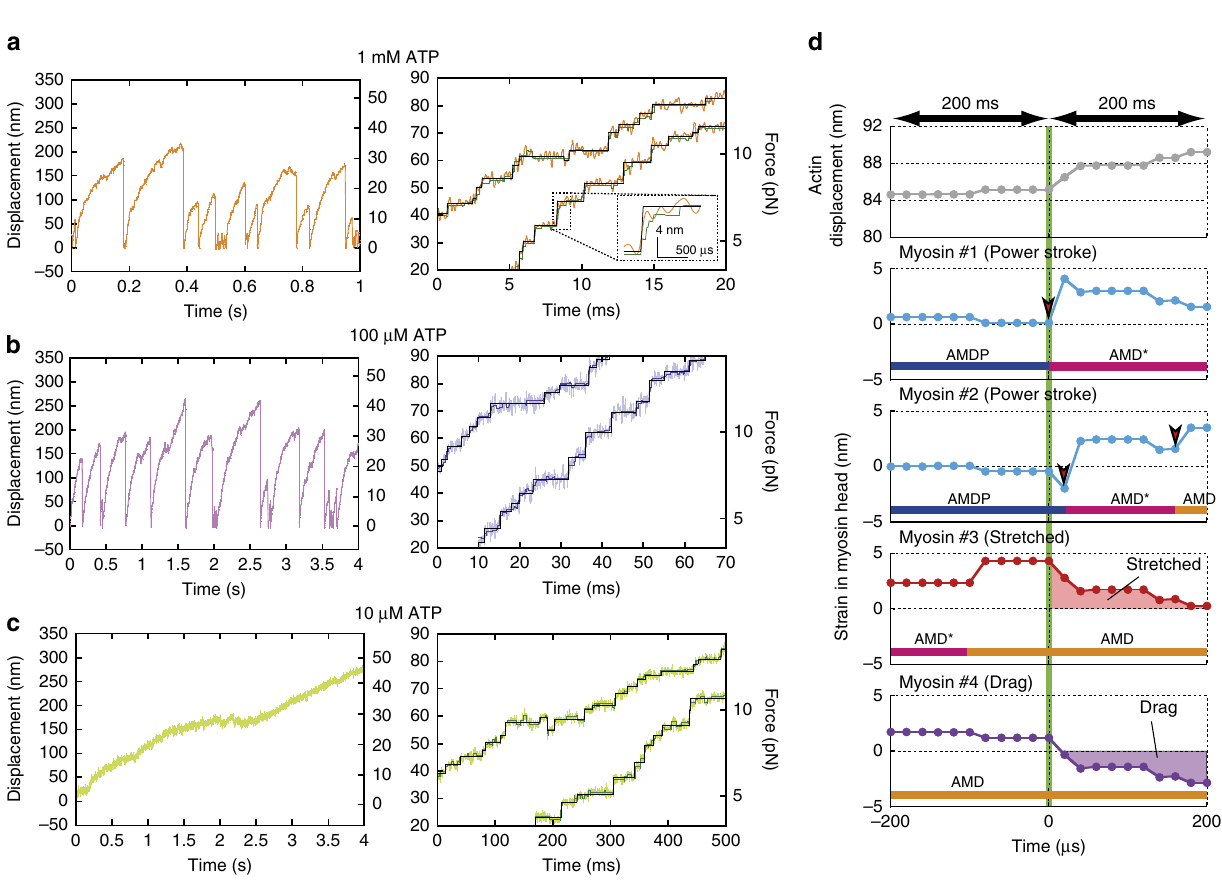
Figure 6 | Simulation results for actin–myosin interaction. ( a – c ) Time-course data for the displacement of a single actin filament (left column) at 1mM, 100 m M and 10 m M ATP in a – c , respectively. Stepwise displacements of actin filaments computed by simulation for low loads (right column). Random noise was added to the original computed steps (different coloured lines) to detect steps (black solid line) by using the step-finding algorithm 40 . The inset in a shows a zoomed-in plot of the box region, which shows a single step (black) generated by contiguous power strokes (green). ( d ) Time course of a single actin step (top) and corresponding strains of myosins bound to actin filaments (bottom) within ± 200 m s of the onset of the step, as indicated by the green vertical line. In this example, four myosins, #1–#4, engage with an actin filament during step generation. Myosins #1 and #2 execute multiple power strokes, as highlighted by the red arrowheads, whereas myosins #3 and #4 have already completed power strokes. Thus, they remain bound to actin as a ‘stretched’ or ‘drag’ motor, respectively. Red or purple shaded regions indicate whether an average strain at t 4 0 is positive (stretched) or negative (drag). The horizontal colour bars in each panel indicate transition states.